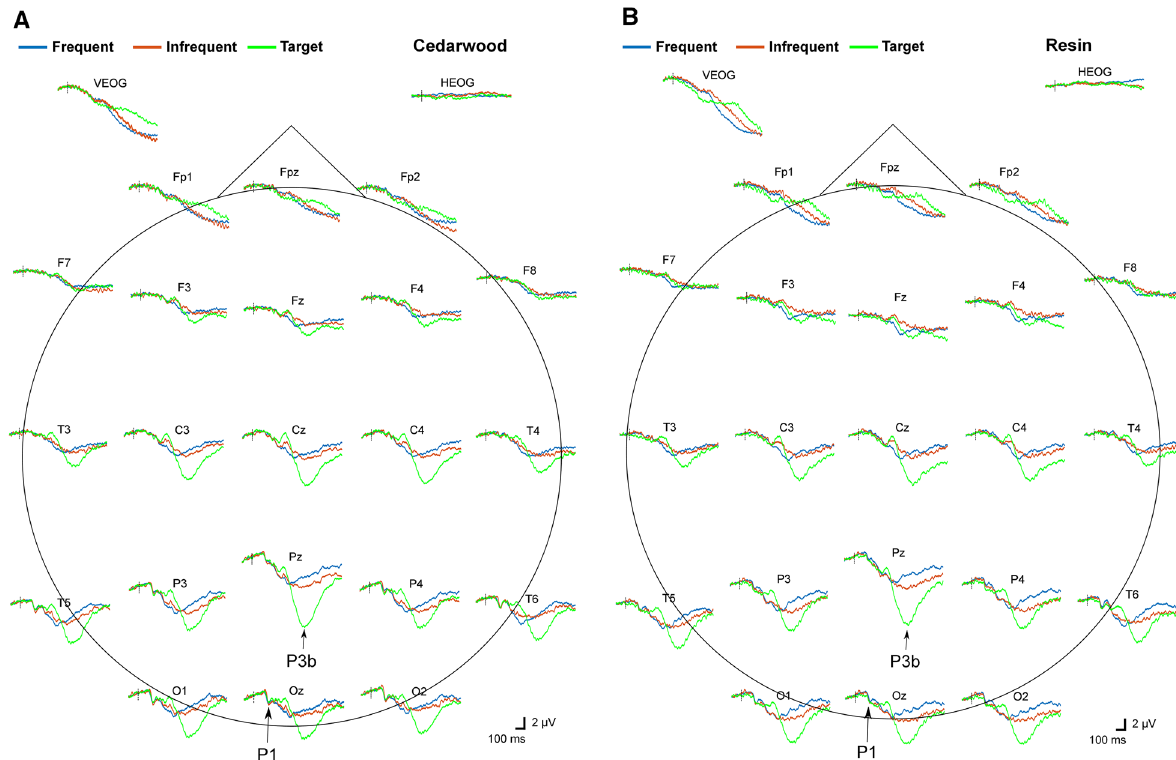
Fig. 4 Topographical mapping of grand-averaged ERPs under the cedarwood and resin conditions. The P1 components were elicited at the occipital region (Oz). P3b was predominantly recorded for the target stimuli at the parietal site (Pz) in both the cedarwood ( A ) and resin ( B ) huts. The latencies of the P1 and P3b components were almost the same regardless of the hut condition. Note that P1 was evoked at Oz, and P3b was recorded only for the target stimuli predominantly at Pz regardless of the hut